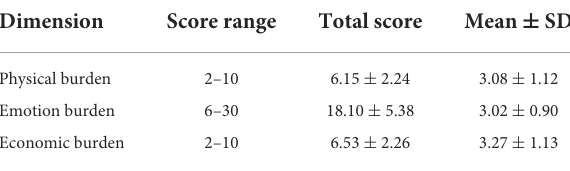
TABLE 2 Each dimensions score of SPBS in adult epilepsy patients ( N =